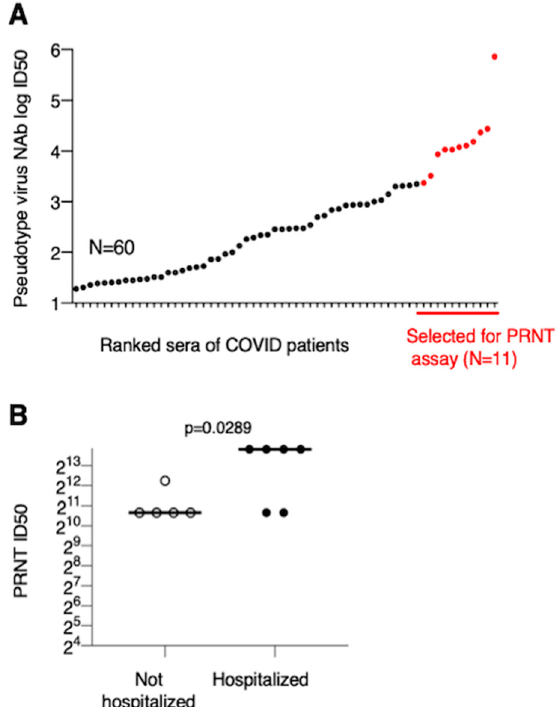
Figure 5. Live-virus neutralization by sera with high pseudotype virus NAb titers. ( A ) The ranked log ID50 values from 60 sera measured at screening are plotted. Eleven sera with the highest PsNAb are marked in red. ( B ) Live-virus neutralization measured as PRNT ID50 values (log2 transformed) are compared from not hospitalized and hospitalized patients. PRNT ID50 > 4860 are plotted as 14,580, reflecting the next dilution. P value is from an unpaired parametric t -test.